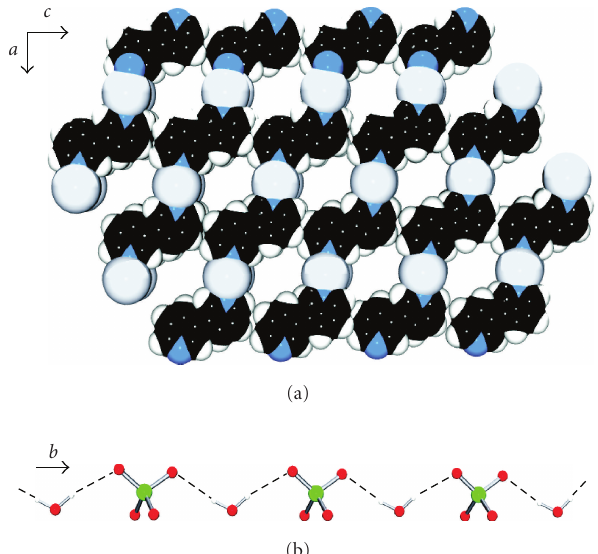
Figure 4: (a) Section of the packing pattern in 1 (excluding H 2 O and ClO 4 − ), including voids along the b direction. (b) Water- perchlorate hydrogen bonded polymer inserted along the packing tunnels of 1